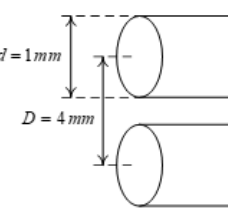
Figure 28. Dimensions of the transmission